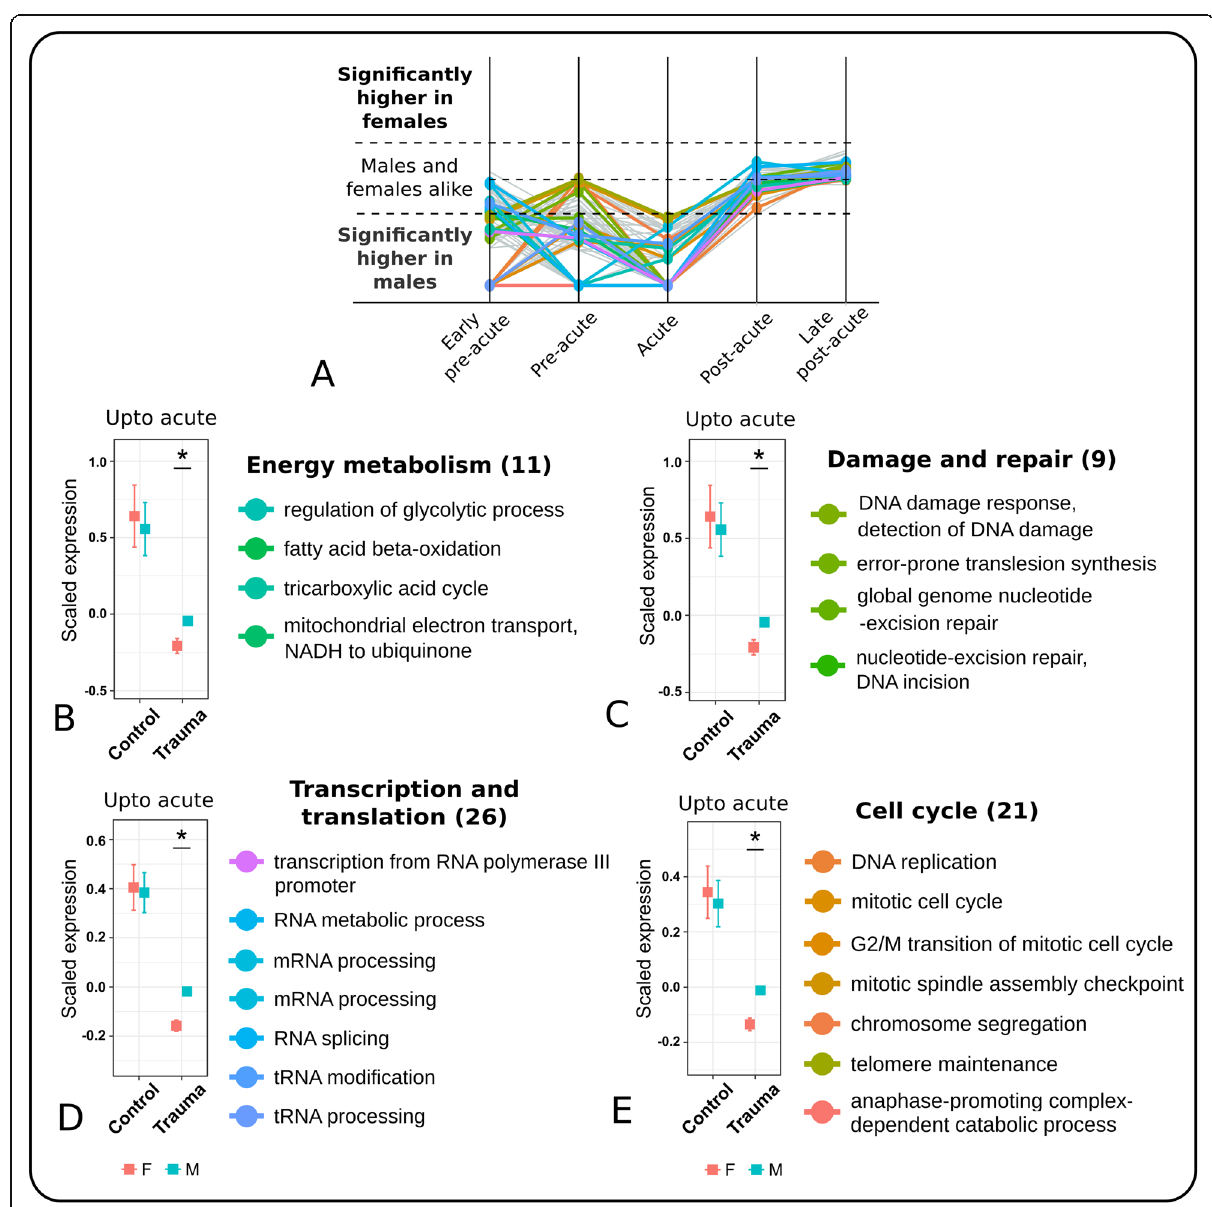
Fig. 4 The gene set cluster of the early pre-acute, pre-acute and acute phase. a The cluster consisted of 85 gene sets being downregulated in female patients. Most of these were associated to b energy metabolism and the mitochondrion (11 gene sets), c cell cycle (21 gene sets), d transcription and translation (26 gene sets), and d damage and repair (9 gene sets). For each category, their representative gene sets are listed here. The complete list is given in Additional file 1: Fig. S10. In comparison to healthy controls, for all categories, leukocytes of both sexes showed a lower expression of these gene sets, but relatively lower expression was observed in female patients. The z-transformed expression values were referred to as ‘ scaled expression ’ values. Significance of difference between the expression of genes of male and female patients was tested using two-sided Student ’ s t-tests (* P <0.05, mean bar and Whiskers of the boxplots: